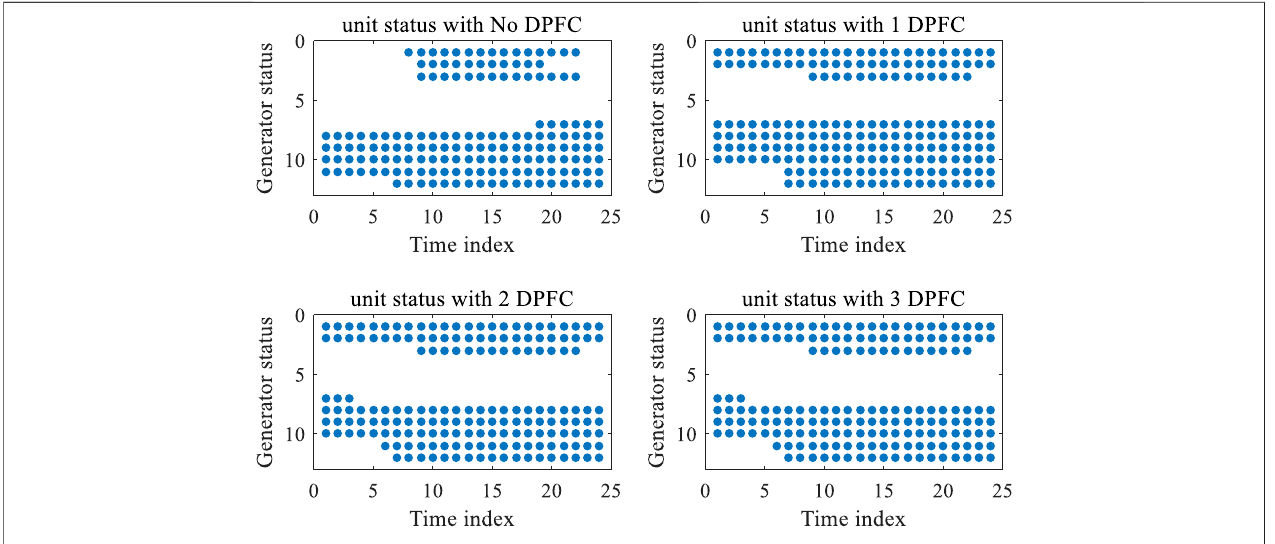
FIGURE 8 | Thermal generator state with different numbers of the